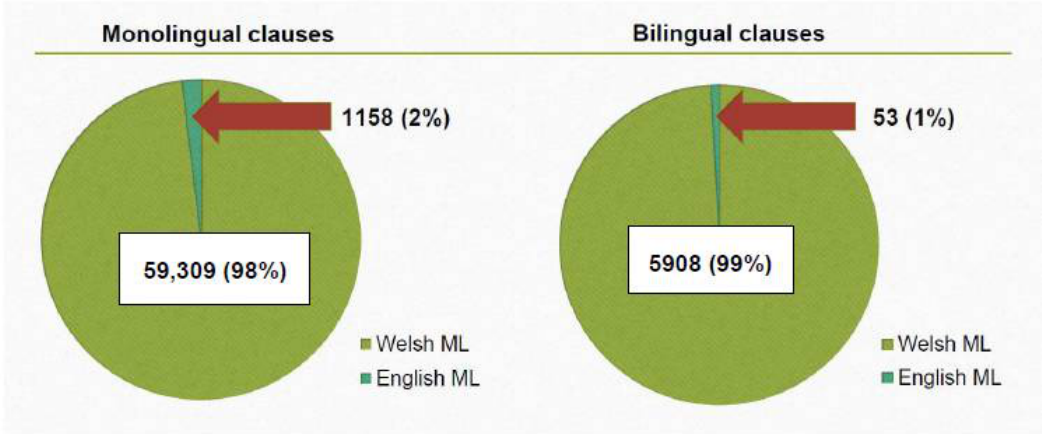
Figure 5. Quantitative distribution of matrix language in Siarad corpus.